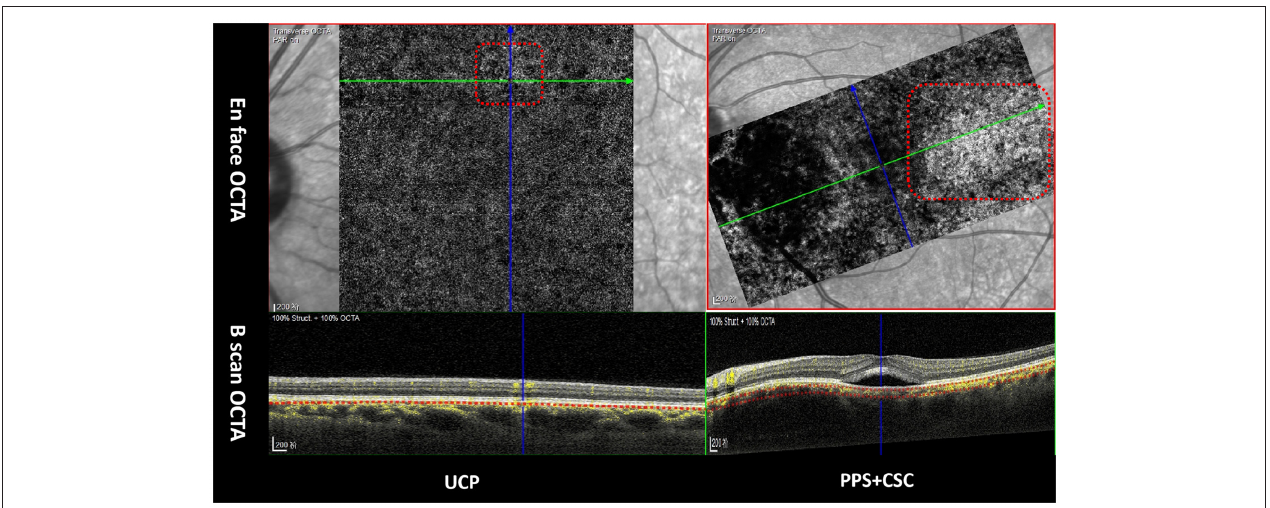
FIGURE 3 | Patched hyper-reflective lesions in choriocapillaris layers in OCTA (red dotted box). Green arrows in upper line indicate the orientation of B-scan OCTA in lower